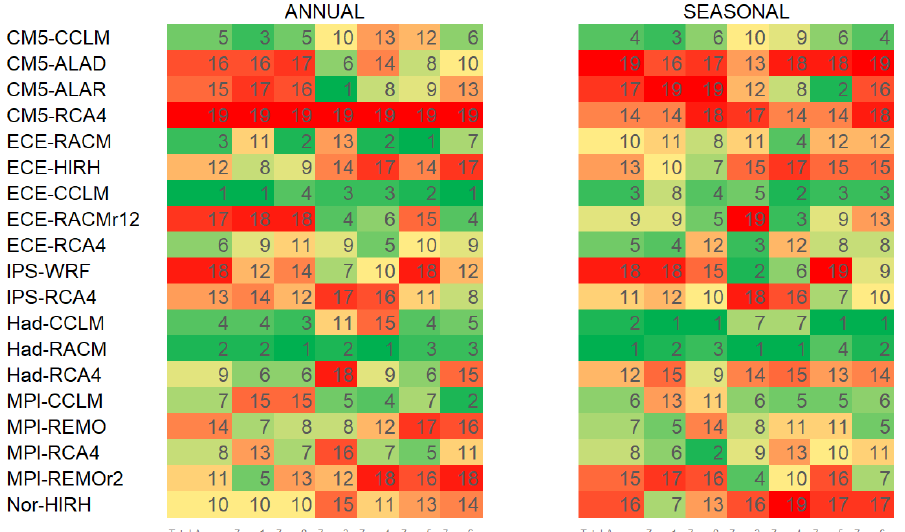
Figure 14. RCM ranking with respect to their ability to reproduce both observed drought maximum intensities and return periods of drought events with duration L = 3 years (left) and L = 4 seasons